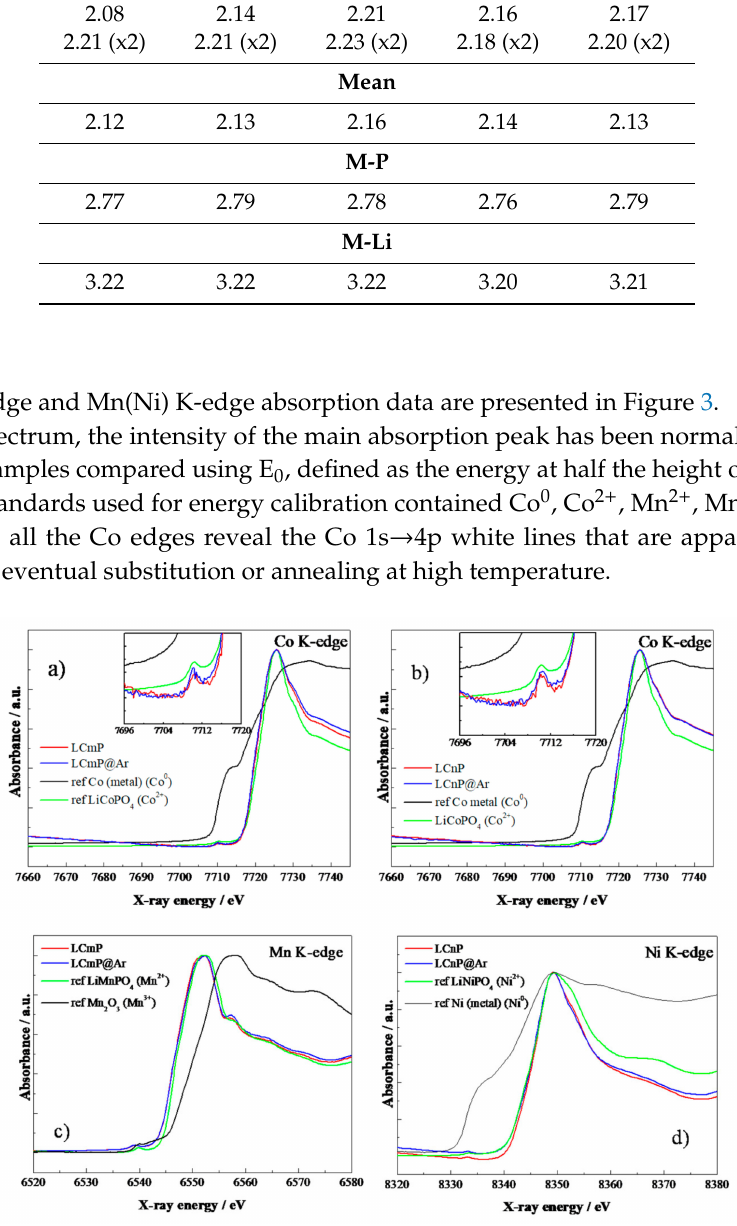
Figure 3. XANES spectra of ( a ) LCmP and LCmP@Ar at the Co K-edge, ( b )LCnP and LCnP@Ar at the Co K-edge, ( c ) LCmP and LCmP@Ar at the Mn K-edge, ( d )LCnP and LCnP@Ar at the Ni K-edge. In the insets, the pre-edge regions are